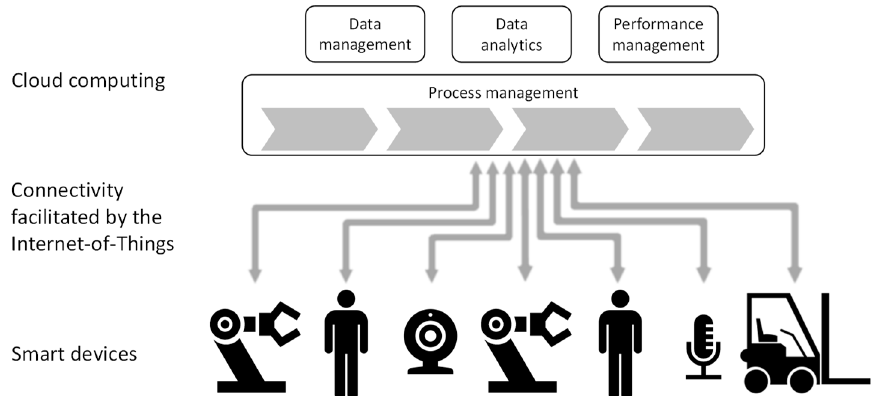
Figure 1. Roles of selected technologies in smart manufacturing.